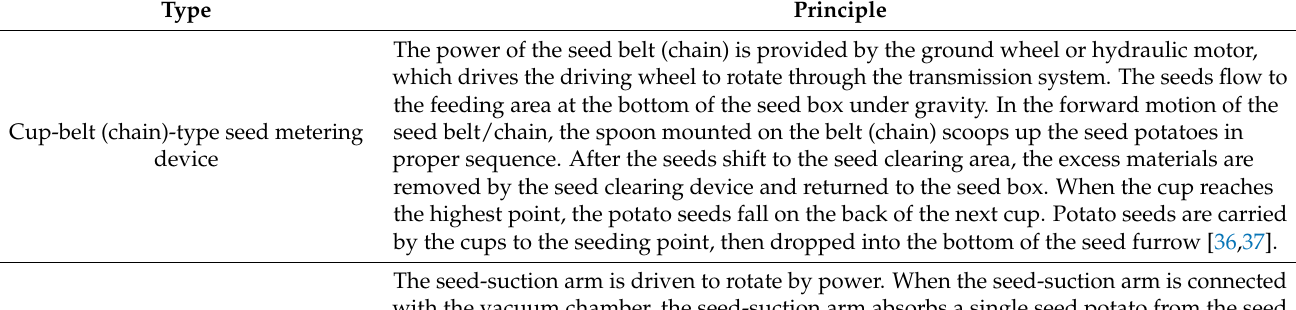
Table 3. Some typical seed metering devices and their